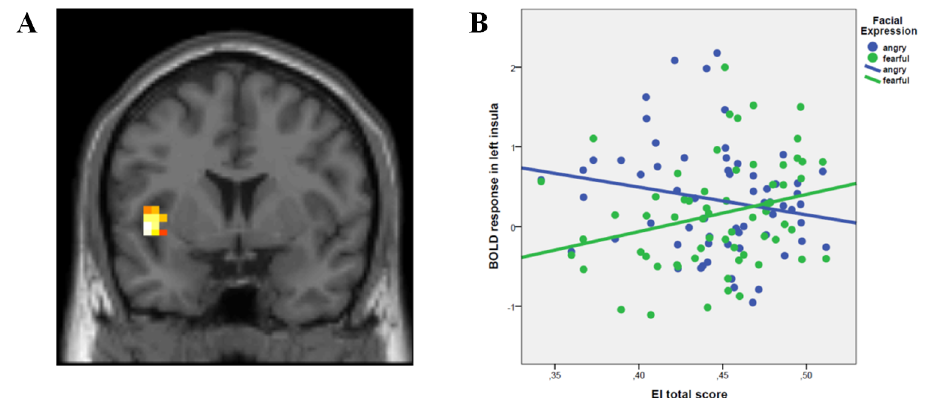
Fig 1. A. Coronal section showing the interaction between EI total score and Facial Expression in left insula. B. Scatterplot depicting the relationship between EI and activity in left insula during social judgment of fearful faces and angry faces. See text for